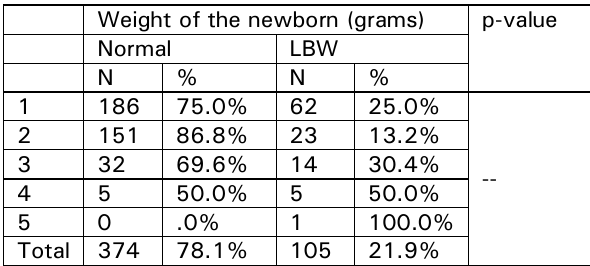
Table 3: relationship of gravidity of mother with LBW Weight of the newborn (grams) p-value